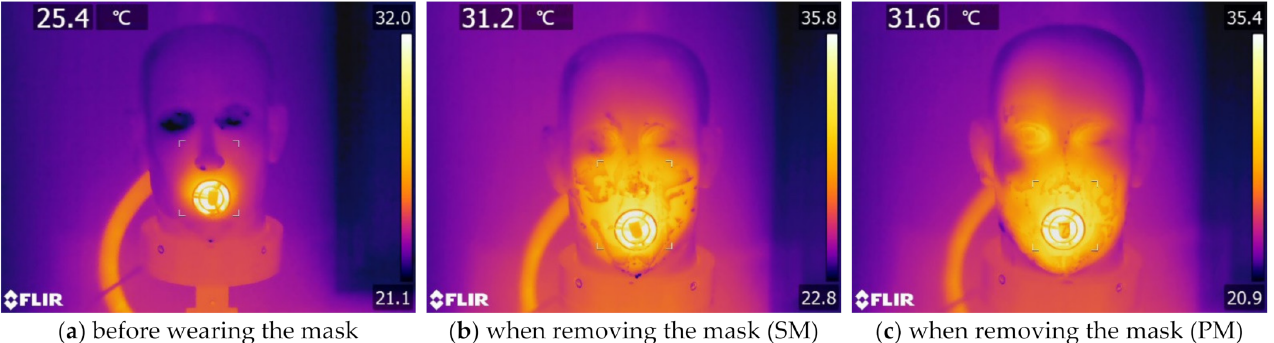
Figure 10. Infrared thermal images of skin temperature after wearing a mask for 8 h (the average temperature of the lips, nose, and cheeks is displayed in degrees Celsius in the upper-left corner).